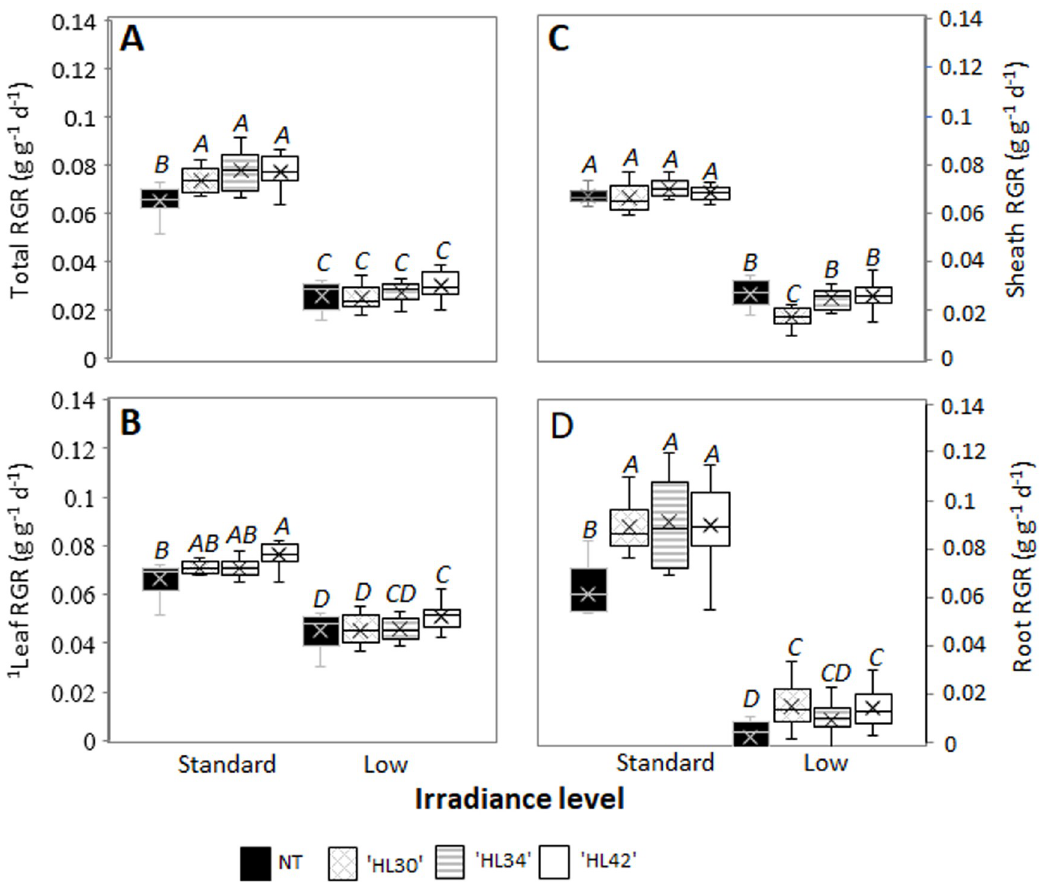
Fig 1. Box and whisker plots of relative growth rate (RGR, g g -1 d -1 ). A RGR of total mass, B leaf RGR, C sheath RGR and D root RGR of high lipid (HL) Lolium and non-transformant (NT) control grown under standard and low lights. A-D Alphabets indicated significant differences (p < 0.05). df = 71 ( n = 9 or 10 ). 1 Data were analyzed using log-transformation. RGR calculated as (ln W 2 – ln